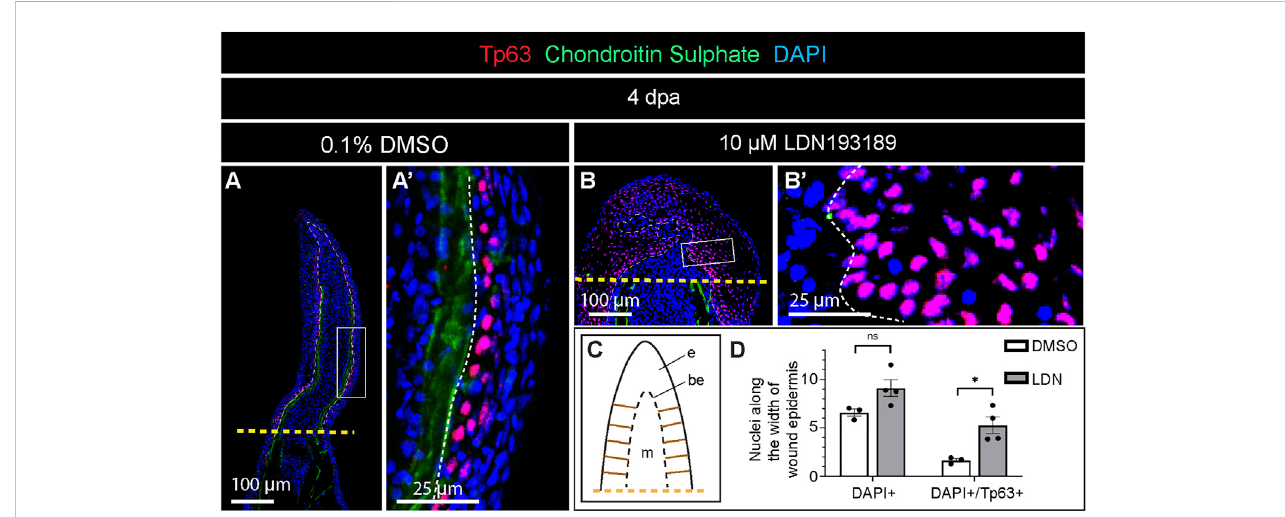
Expansion of Tp63 expression across the layers of wound epidermis in fi ns treated with the BMP inhibitor during regeneration. (A and B) Immuno fl uorescencestainingof fi nsectionsat4 dpawithantibodiesagainstchondroitinsulphate(green)tovisualizelepidotrichia,andTp63(red),amarkerof thebasal epithelium.DAPI(blue)demarcates nuclei.Orange dashedlinesshow theamputationplane,whitedashedlinesunderlythebasalwoundepithelium. (C) A schematic representation of the fi n outgrowth with ladder-like brown lines on each side of the wound epidermis, indicating the approximate positions along which the measurements were performed for quanti fi cation of nuclear layers. (D) Quanti fi cation of nuclei along the width of the wound epidermis as illustrated in (C) . N = 3 fi ns (control) N = 4 (LDN193189-treated fi ns); three ray sections per fi n; error bar SEM; n.s., not signi fi cant, * p < 0.05; unpaired two-tailed Student ’ s